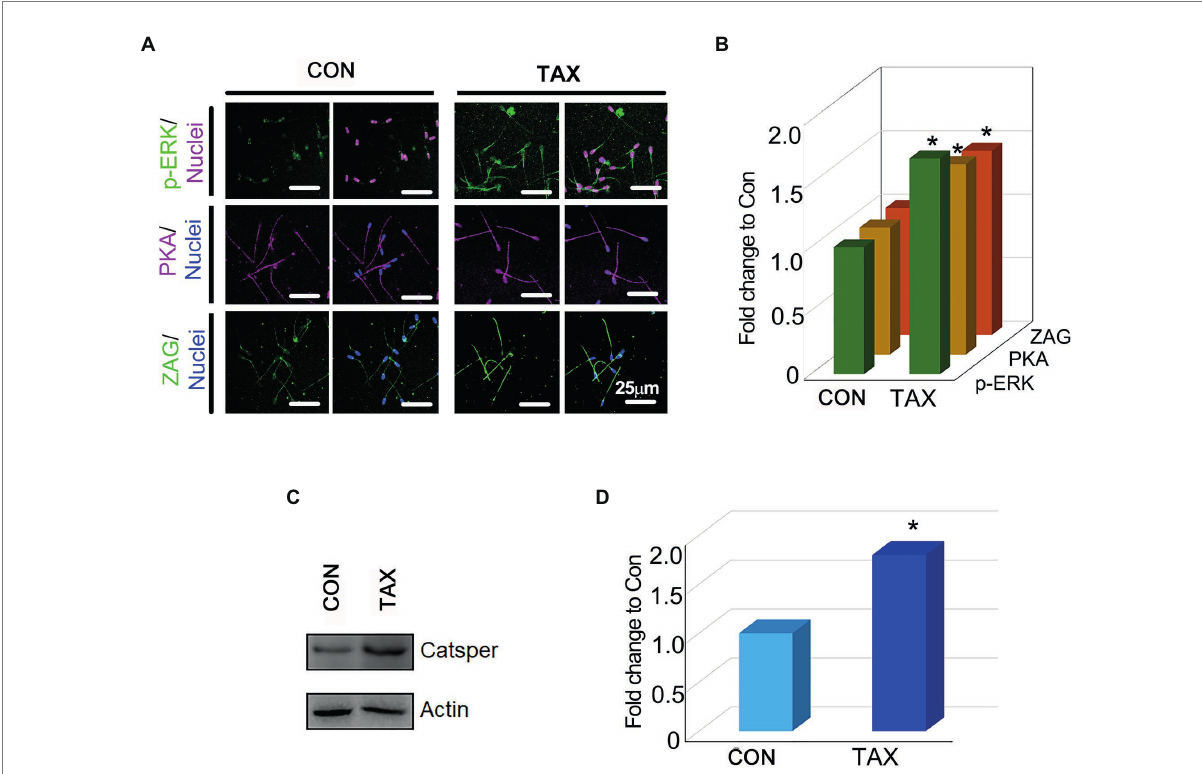
FIGURE 2 Effects of TAX on the protein expression of important genes related to sperm quality. (A) Immunofluorescence staining (IHF) of p-ERK, PKA, and ZAG. (B) Quantitative data for IHF staining of p-ERK, PKA, and ZAG (Fold change to CON). (C) Western blotting (WB) of Catsper. (D) Quantitative data for Catsper staining (Fold change to CON). * p <